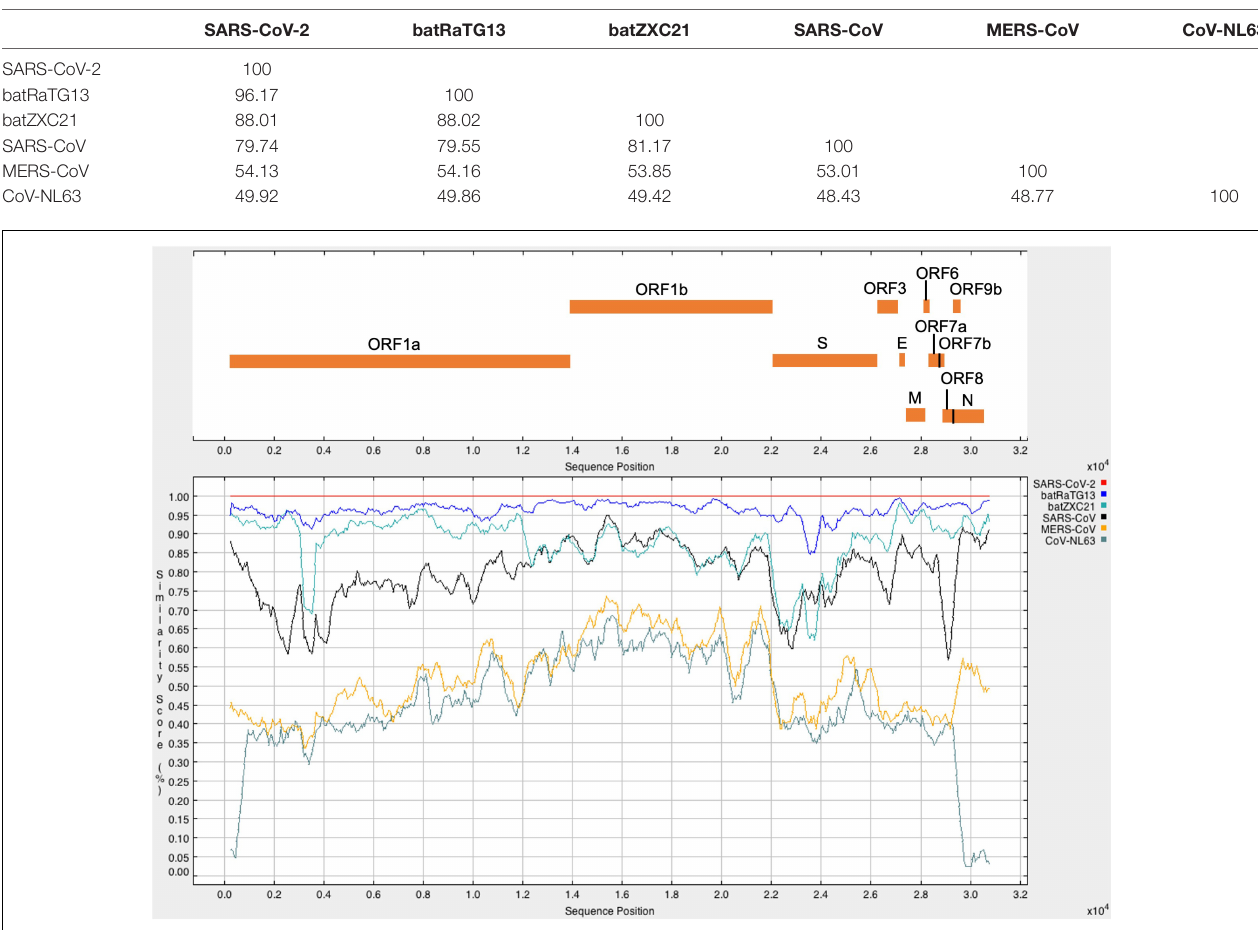
TABLE 1 | Percentage identity score of CoV calculated by CusatalW2.1